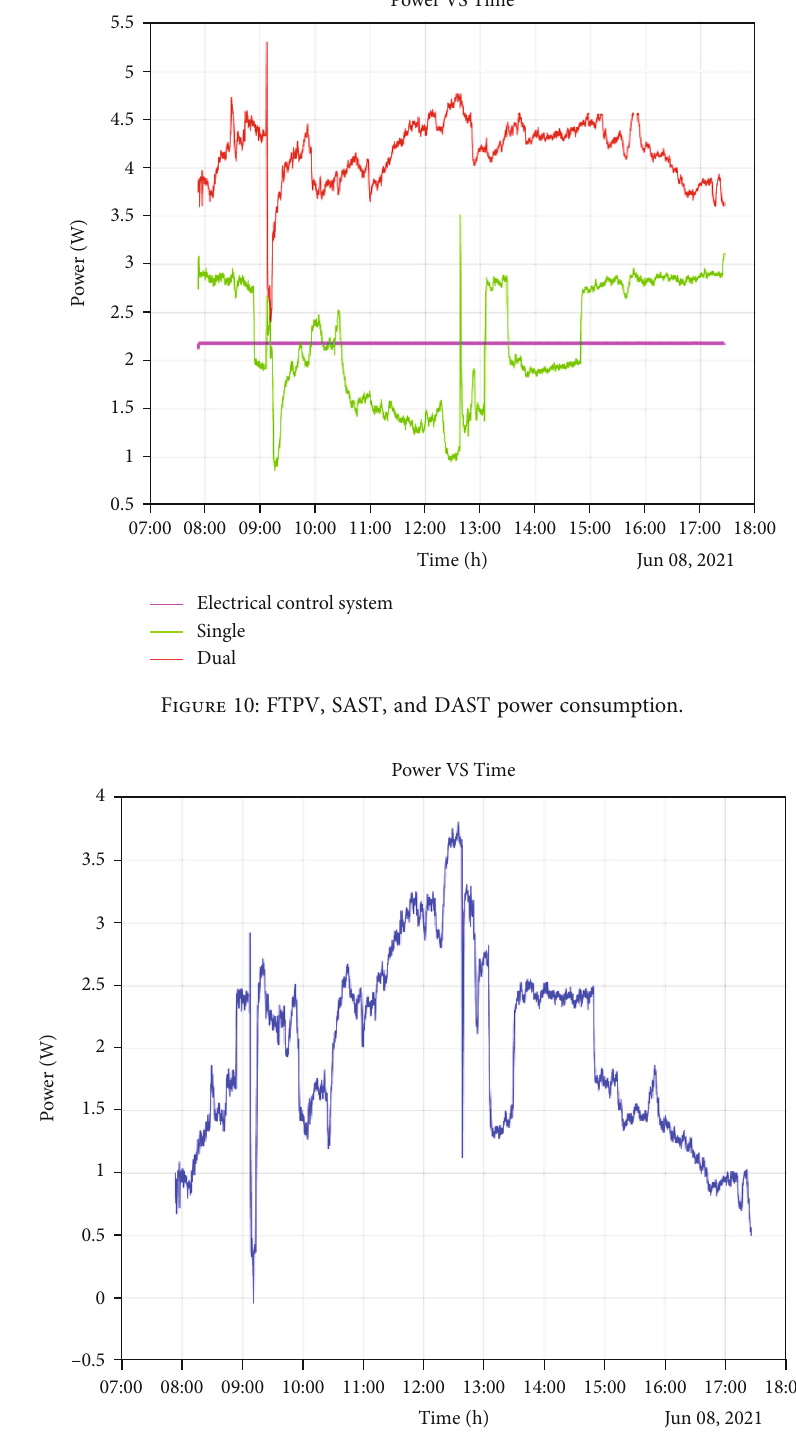
Figure 11: The di ff erence in power consumption between DAST and